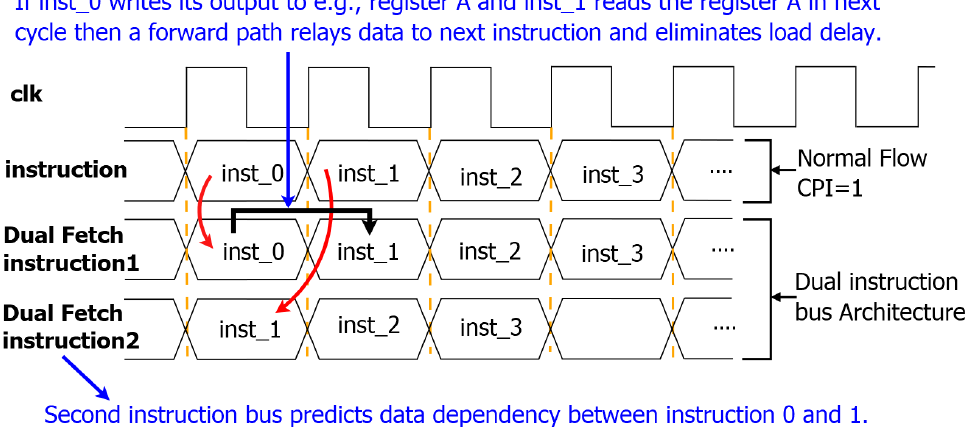
Figure 8. Description of the dual-fetch mechanism showing load delay elimination using two instruction buses.